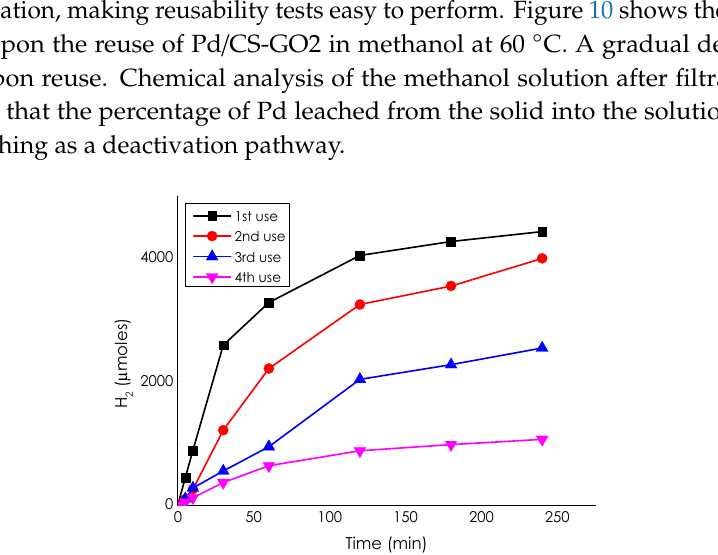
Figure 10. Temporal H 2 evolution upon reuse of Pd/CS-GO2: ■ 1st use; ● 2 nd use; ▲ 3rd use; and ▼ 4th use. Reaction conditions: 10 mmol of ammonium formate, 10mL of methanol, 60 °C, and 11.75 µmol of Pd.